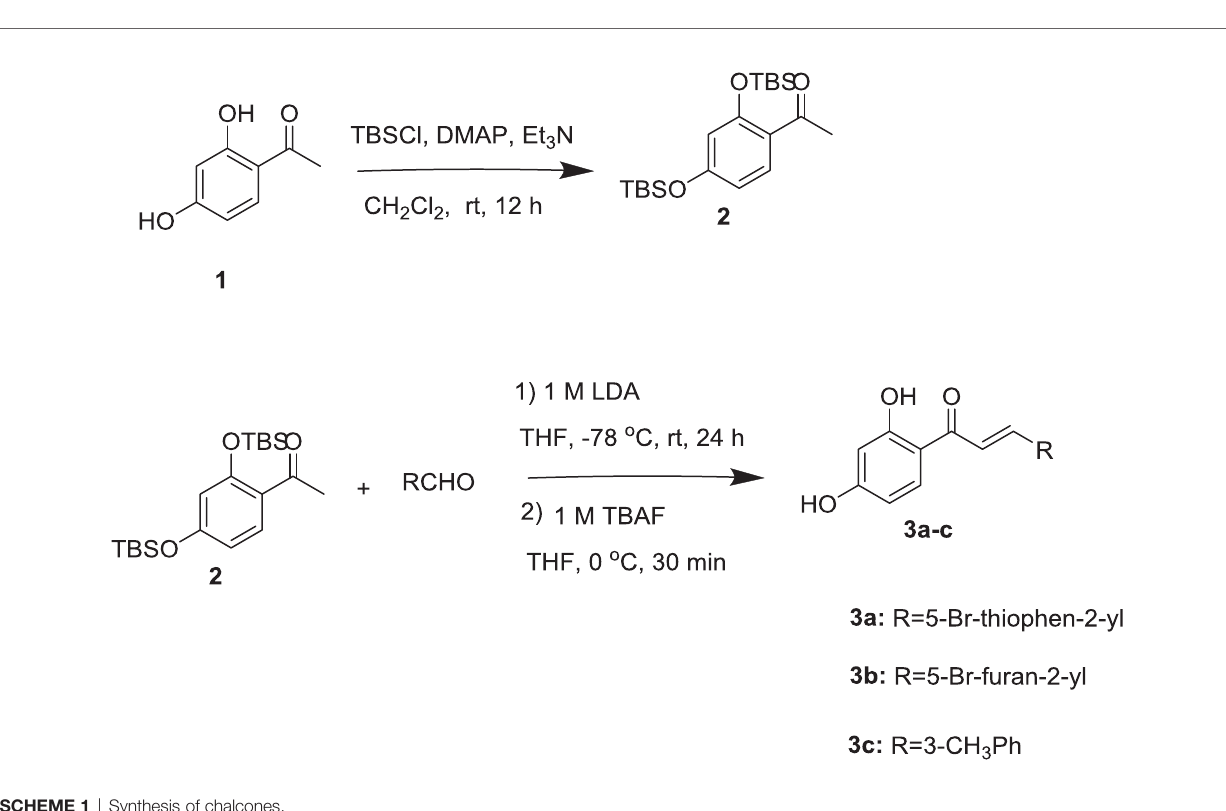
SCHEME 1 | Synthesis of